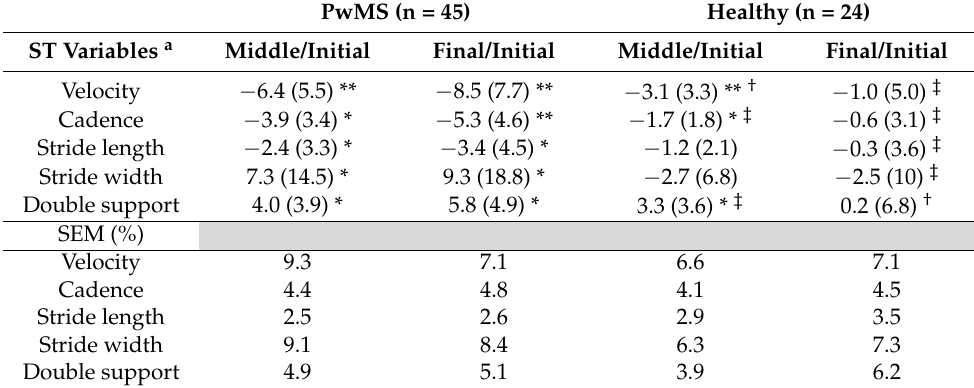
Table 3. Changes and standard error of measurement between middle/initial and final/initial intervals in each group (e.g., PwMS and healthy groups) and between